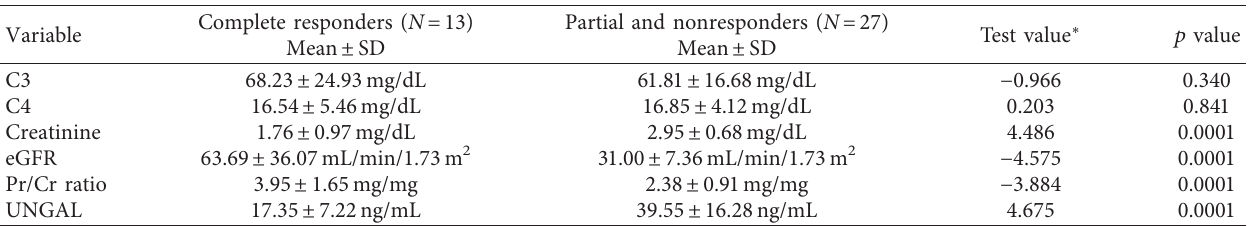
Table 4: Comparison between complete responders with partial and nonresponders as regards to baseline renal biomarkers. Variable